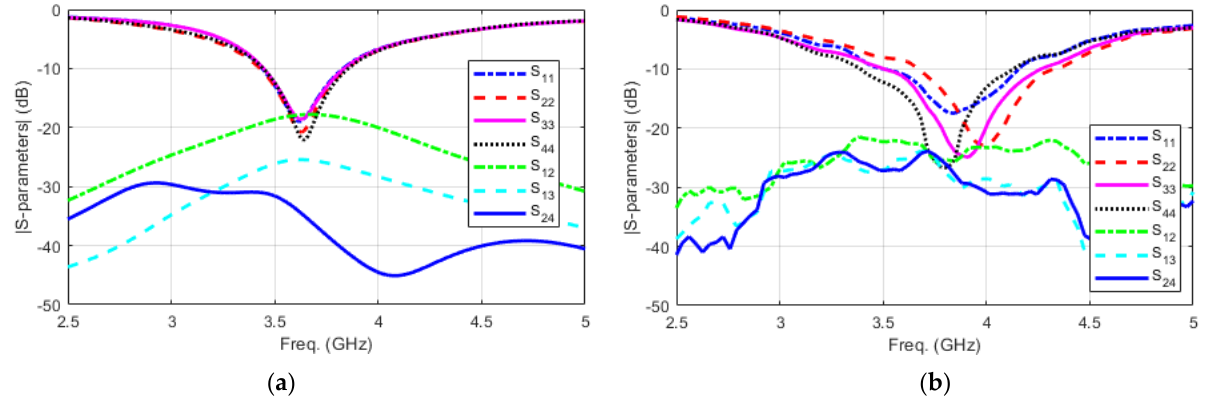
Figure 6. S − parameter curves for Ant.1 to Ant. 4 at 5G Sub-6 GHz band: ( a ) simulated and ( b ) measured.